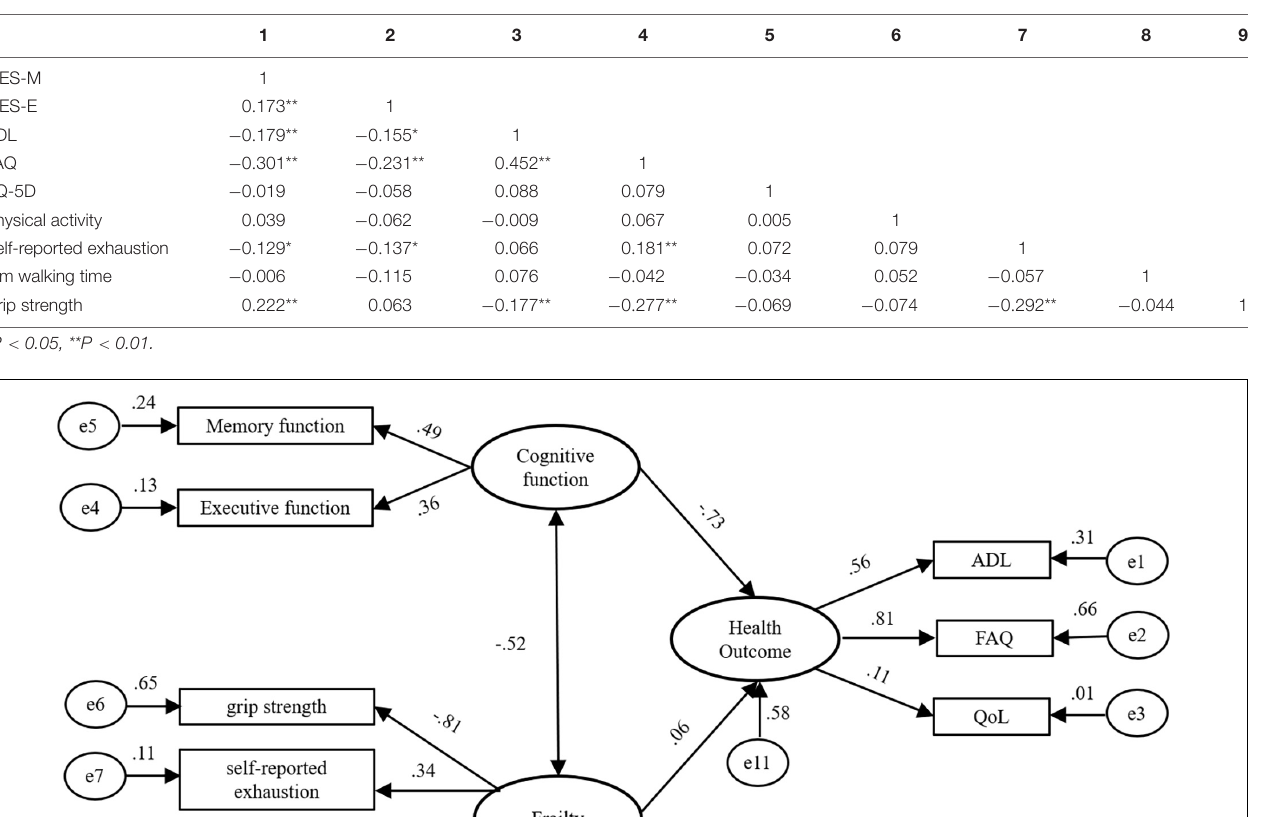
TABLE 3 | Pearson’s correlation coefficient of study variables ( n = 252).